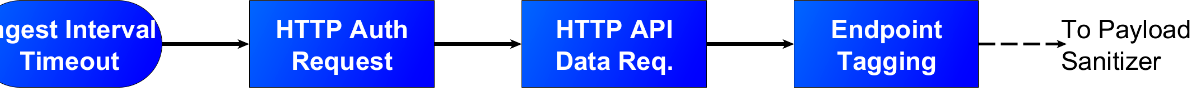
Figure A1. HTTP interval polling-based data ingest step for device data integration.